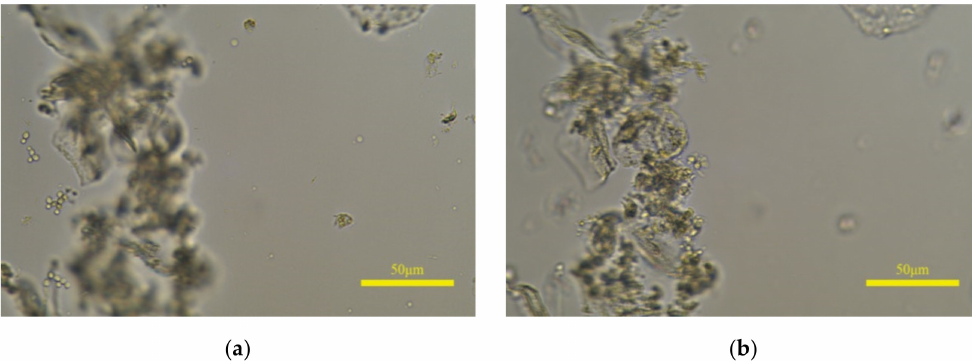
Figure 12. The influence of epithelial cells with large size on prediction results. ( a , b ) are the annotated and predicted clearest image in one image group,